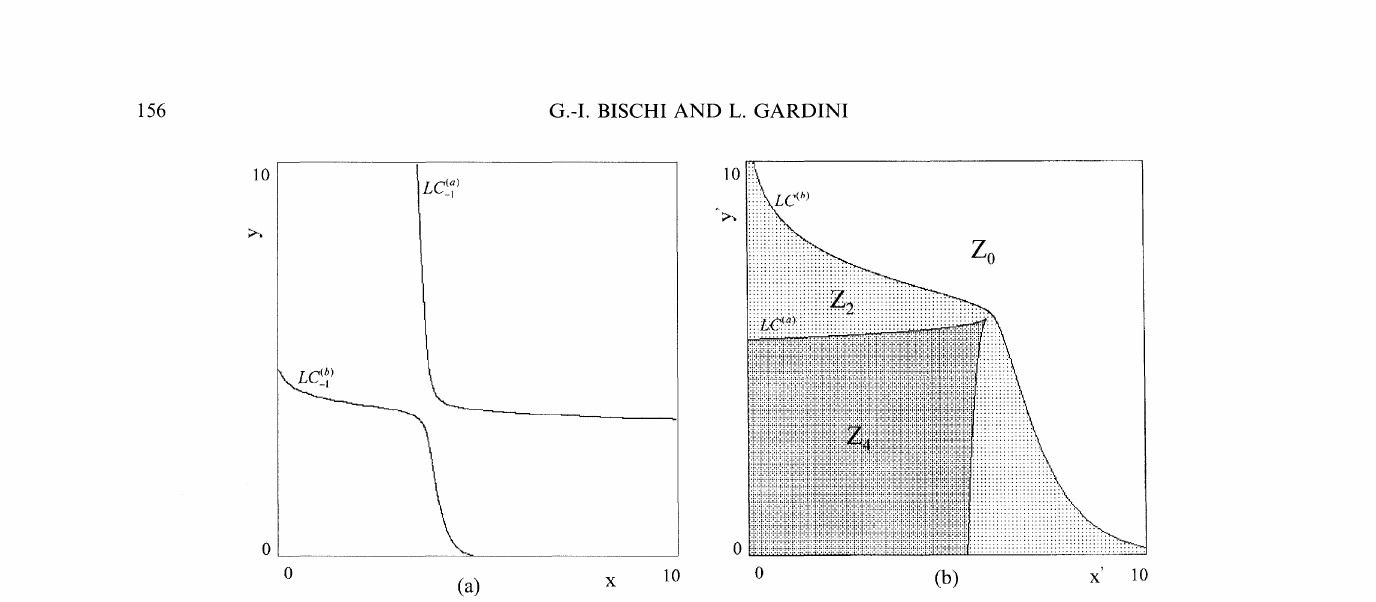
FIGURE (a) Critical curves of rank-0, LC_ for the map (12), numerically obtained as the locus of points where the Jacobian 1, det(DT(x,y))=O, for A=A2=0.5, fl=f12=0.2, B= 10 and k= 1. (b) Critical curves of rank-l, LC=T(LC_). These curves separate the plane into the regions Z4, Z2 and Z0, whose points have four, two, and no rank-1 preimages respectively.